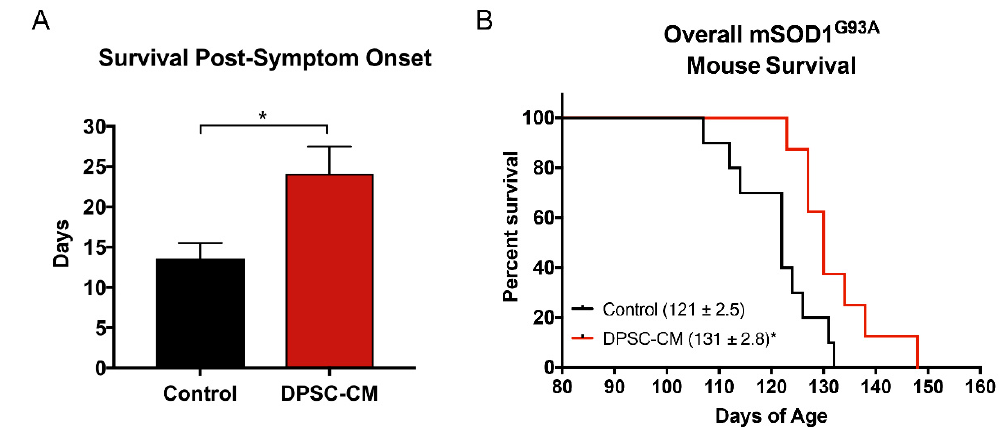
Figure 7. DPSC-CM treatment beginning at symptom onset significantly increased post-onset survival and overall lifespan of mSOD1 G93A mice. Daily DPSC-CM treatment from symptom onset until end-stage (point of humane euthanasia) significantly increased ( A ) post-onset survival and ( B ) extended overall lifespan in mSOD1 G93A mice by ~10 days compared to vehicle treatment. *, p < 0.05. ( n = 8–9).